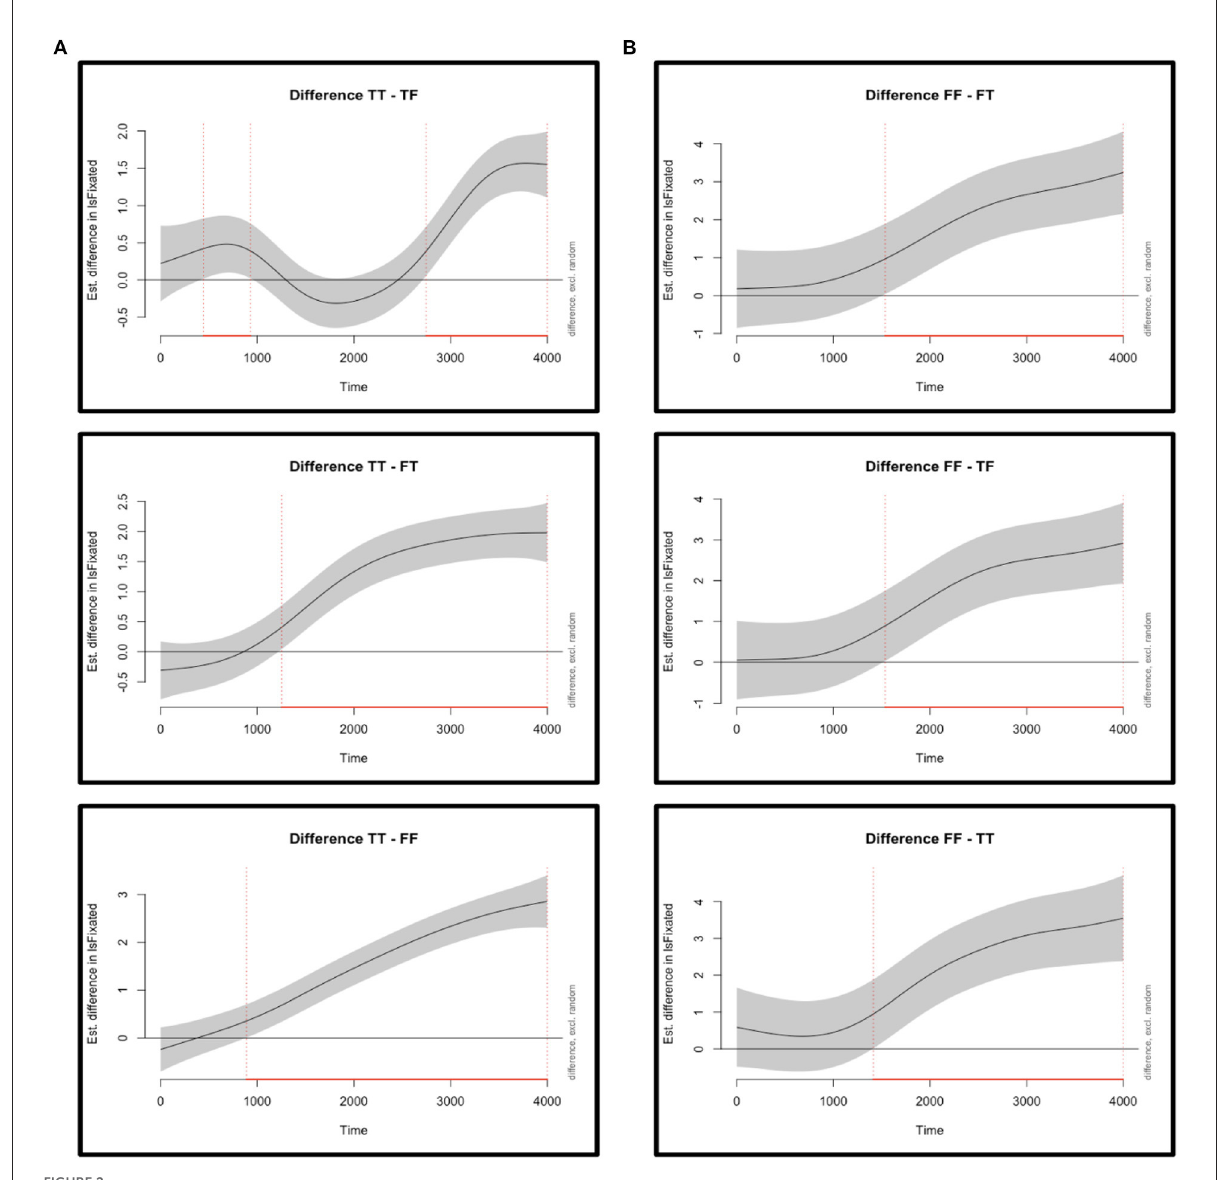
FIGURE2 Difference curves, derived from the best-fit model of a generalized additive mixed-model analysis. The graphs show the comparison between the (non-linear) smooth of the quadrant with the most fixations (fixations are labeled as IsFixated on the y-axis) against each of the (non-linear) smooths of the other quadrants, with the gray solid line indicating the estimated difference. The shaded band represents the pointwise 95 % -confidence interval; when the band doesn’t overlap with the x-axis (i.e., the value is significantly different from zero), this is indicated by a red solid line on the x-axis along with red vertical dotted lines. The graphs show fixations during the audio of the entire sentence in addition to an extra 640–1,000 ms of “looking time” (see Supplementary material for the selection of this time-window for the analyses). (A) Estimated differences from Experiment 1 between fixations to the TT quadrant and fixations to the TF, FT, and FF quadrants. The TT-TF comparison exhibits differences in two time windows, at window 445–930 ms, roughly around the time the first clause is being played in the audio, and at 2,750–3,999 ms, where the beginning of this time-window coincides with the end of the audio. The TT-FT contrast produces a difference at 1,250–3,999 ms, a window that (roughly) starts right after the connective has been presented, while the TT-FF comparison exhibits a